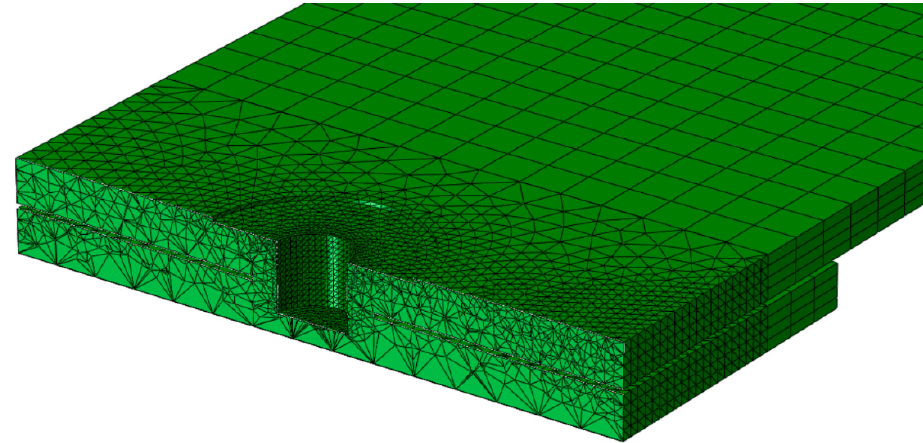
Figure 3. FEM of FSSW joints for structures with a probe hole.